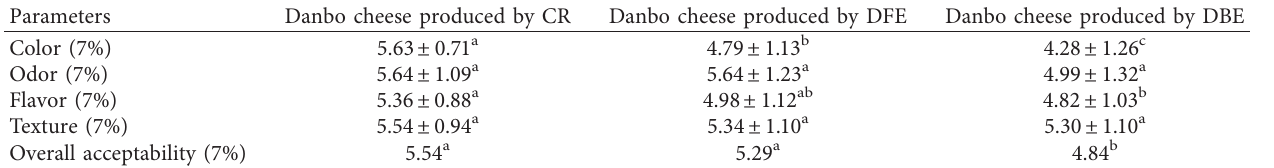
Table 5: Sensorial characteristics of fresh Danbo cheese.